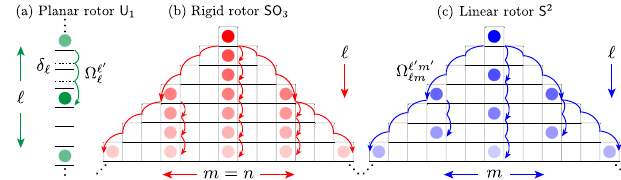
FIG. 6. Microwave dressing. Sketch of the microwave tones required to build the approximate code words out of angular- 3 for U l 6 momentum eigenstates up to j l 1 (a) and max j ¼ max ¼ for SO 3 (b) and S 2 (c). We assume the molecule is initialized in j l ¼ 0 i for U 1 , j 0 00 i for SO 3 , and j 0 0 i for S 2 . An array of microwave tones is applied to construct the code words. Any transition allowed by dipole selection rules can be driven with a Rabi frequency Ω l 0 m 0 l , phase ϕ l 0 m 0 l , and detuning δ l 0 m 0 l . (For SO 3 , m m m we utilize only the n ¼ m states, so no explicit mention of n is necessary for those cases. For U 1 , there are only states with integer l .) Curved lines without arrows illustrate vastly off- resonant coupling to a state for which the population is effectively zero, and the state can be adiabatically eliminated. Curved lines with arrows illustrate couplings with a finite population of the state. To prepare approximate code words in the subspaces shown, at most 12, 24, and 22 unique microwave tones are required for U 1 , SO 3 , and S 2 ,